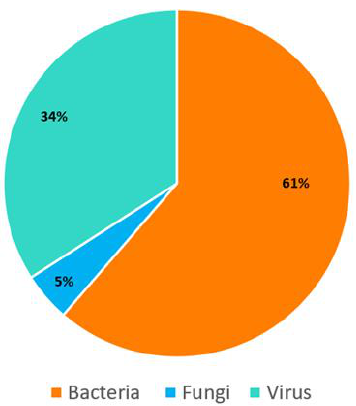
Figure 1. Classification of microorganisms detected by mNGS (coverage ≥ 40.00%, median depth ≥ 1× and RPKM ≥ 10.00). To avoid any errors during position changes, please provide the combined image instead of editable piece in the figure.